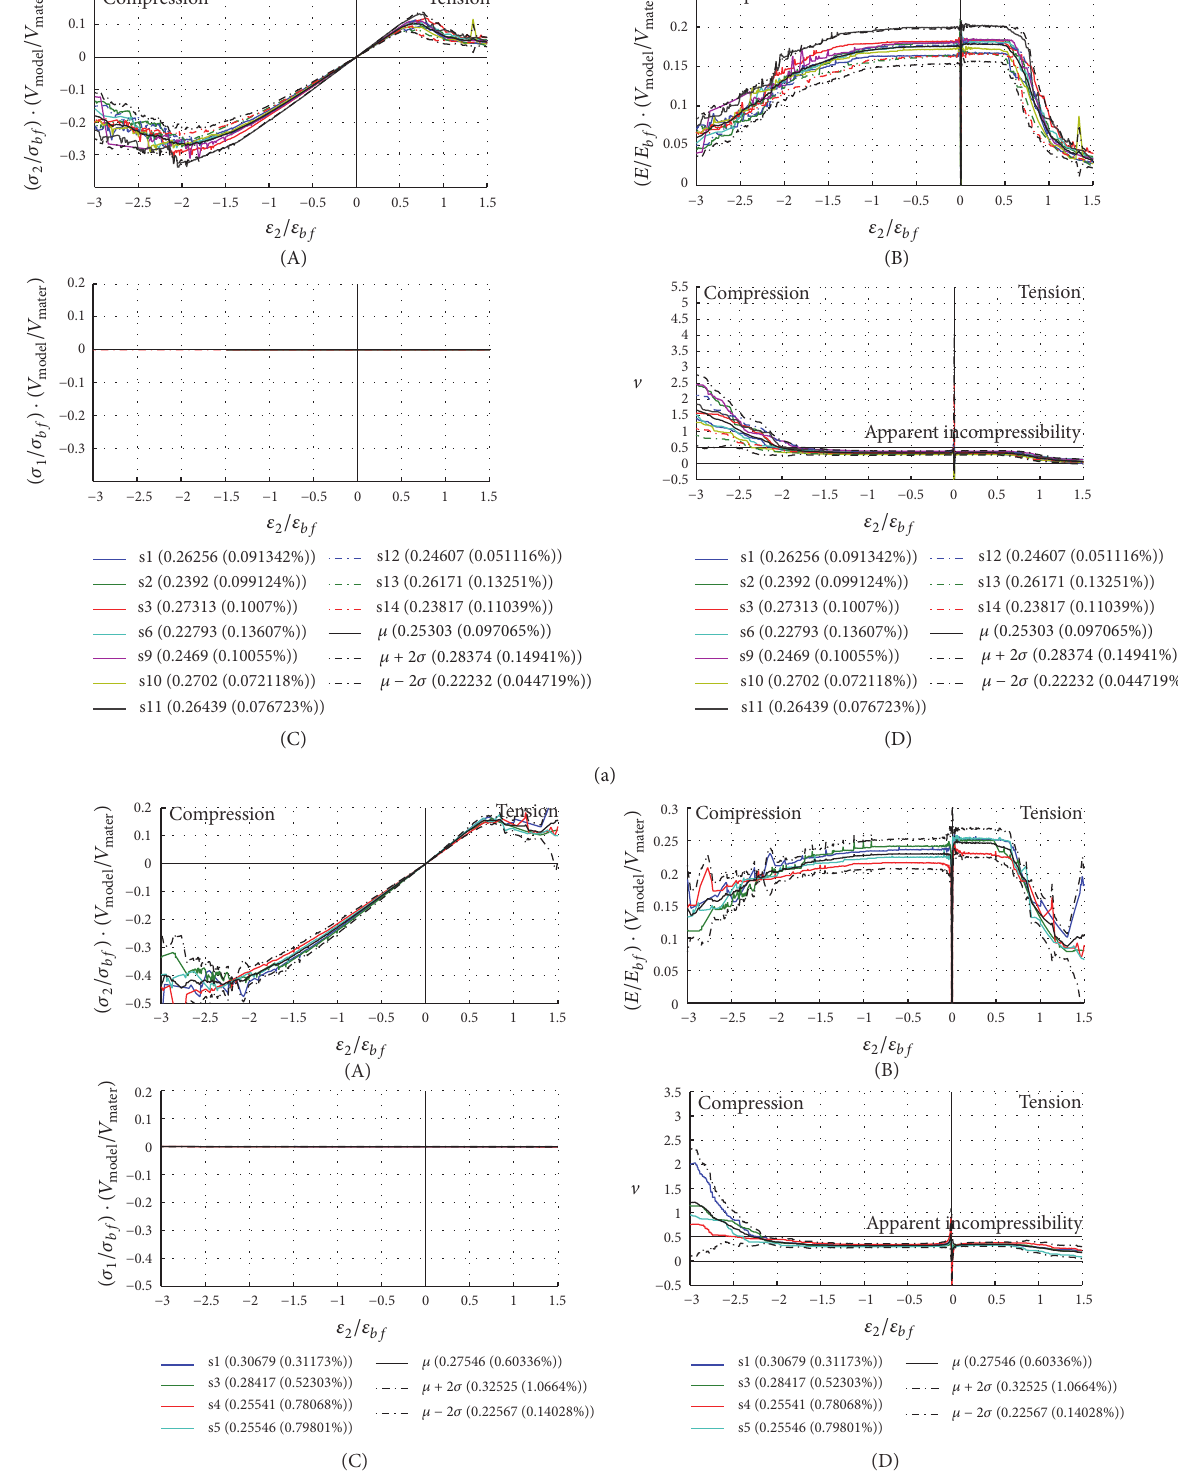
Figure 4: Individual response curves, along with sample mean response curves (in solid black) and 2 𝜎 -envelopes (in dashed dotted black), for uniaxial plane-stress loading of discrete specimens ( 15 × 15 MHD) reinforced with CNTs. Stresses and moduli of elasticity are divided by the observed volume density 𝑉 mater / 𝑉 model of each specimen (given in parenthesis in the legend, along with the actual CNT content per solid volume of specimen). (A) Stress in direction of loading. (B) Secant modulus of elasticity. (C) Stress across loading (zero throughout). (D) Secant Poisson ratio (apparent incompressibility observed at limit point in compression). The two groups differ with respect to the targeted CNT content, which is (a) 0.1% per volume of paste and (b) 1% per volume of